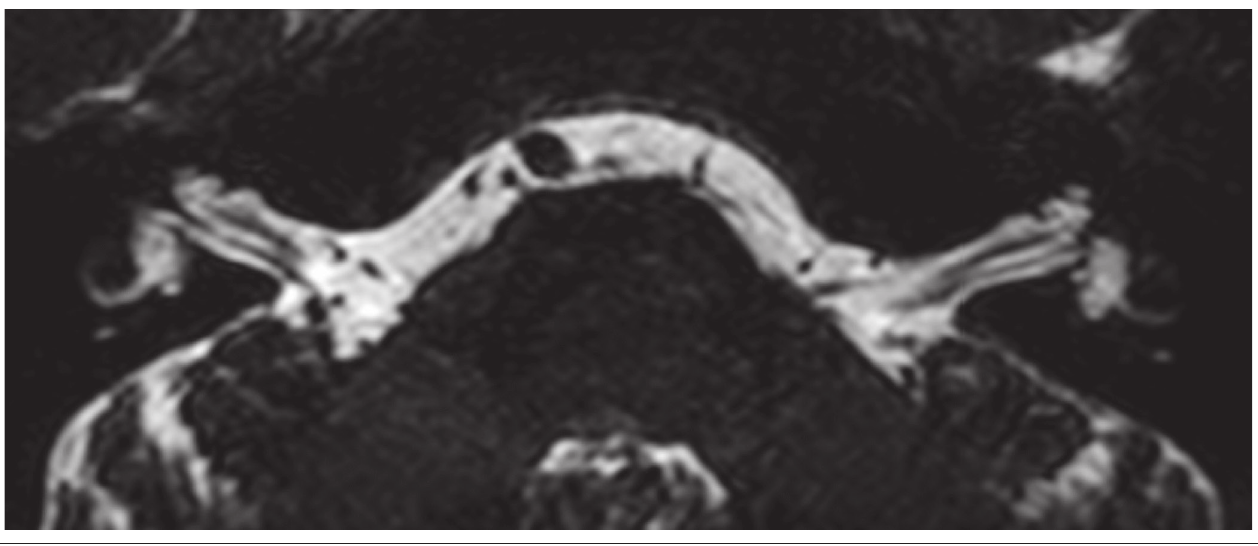
winning respondent will receive R1000 from the RSSA. A detailed diagnosis and discussion will be presented in the next issue of the